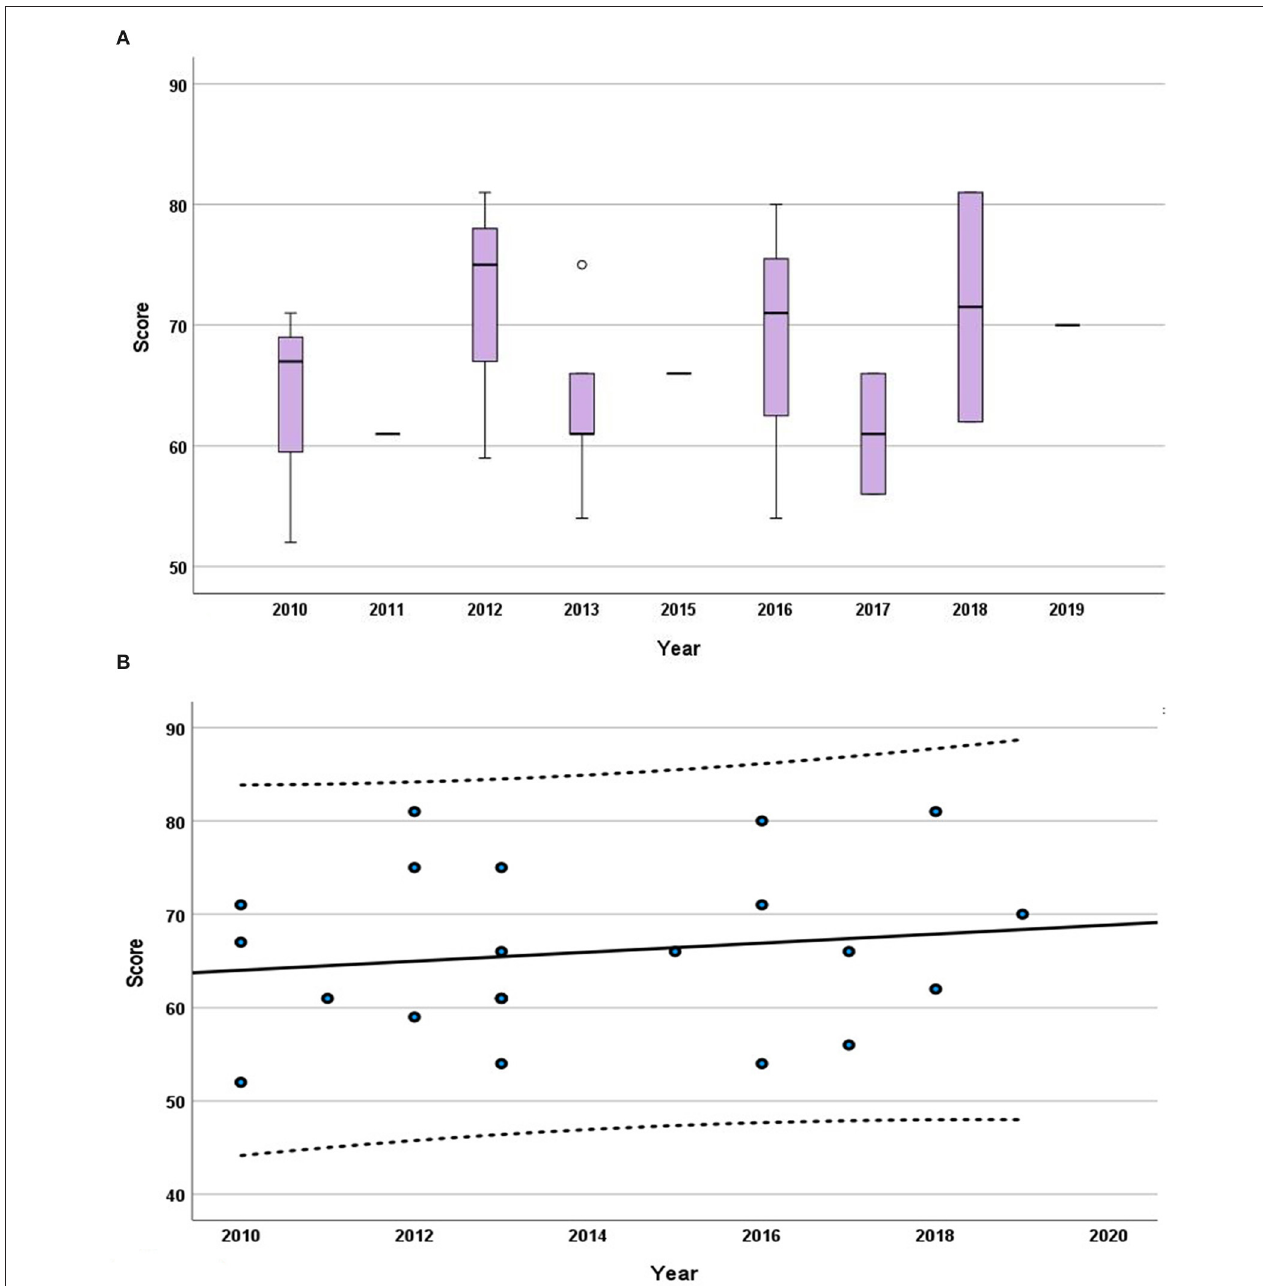
FIGURE 4 | Progression of the grades throughout the years. (A) Box plot displaying the median, interquartile range, minimum, and maximum of the scores for each year from 2014 to 2019. (B) The trendline presented is from the Mann–Kendall trend analysis on the median of the scores. The interrupted lines indicate the 95% confidence